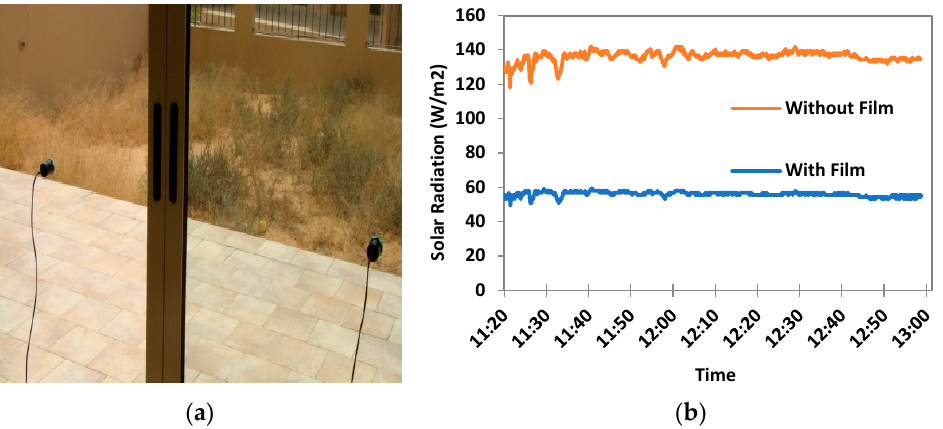
Figure 5. Window glass insulation with thermal film; ( a ) picture showing pyrometer, ( b ) solar radiation measured on glass with film and without film.